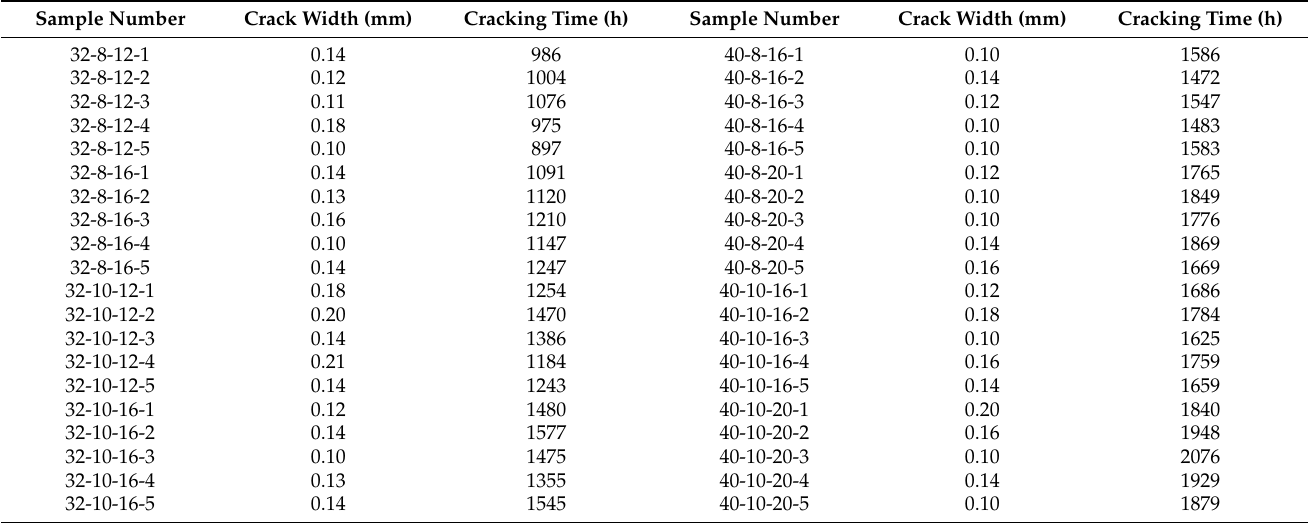
Table 4. Cracking time of concrete covers.